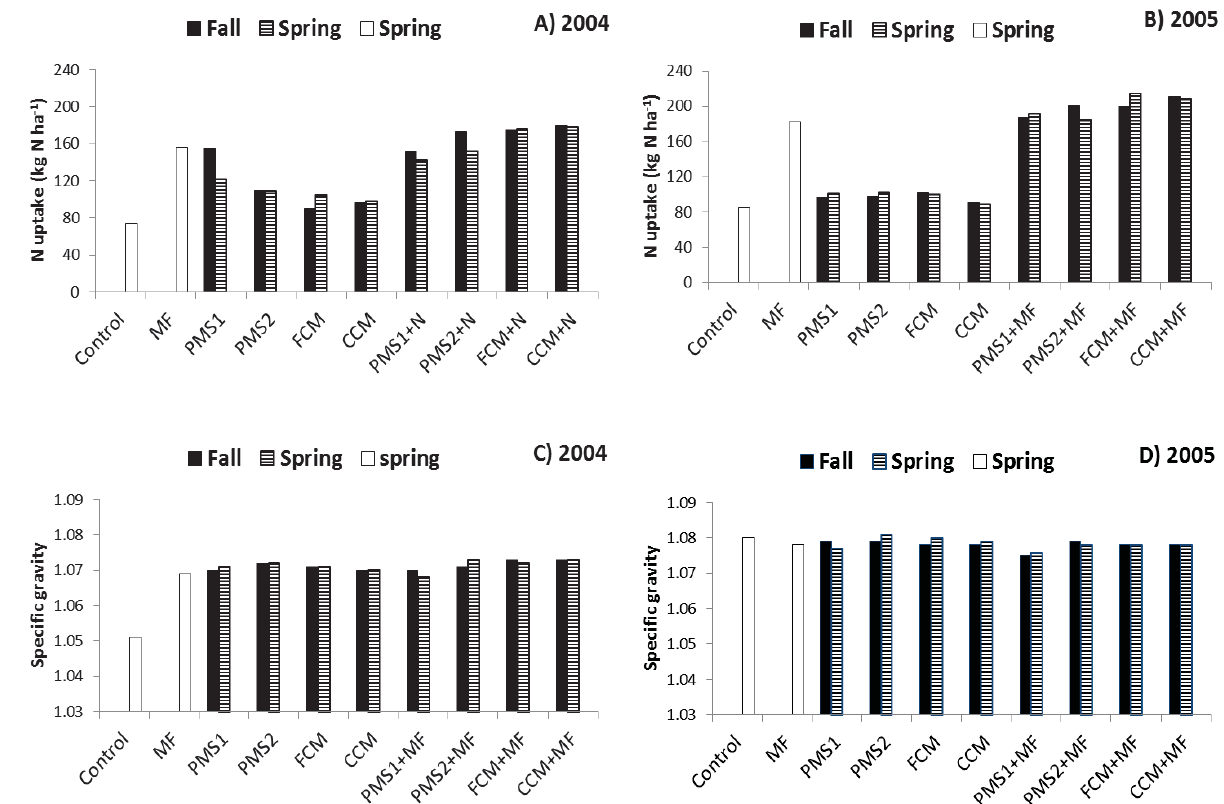
Figure 3. Effects of mineral N fertilization and organic amendments with or without N fertilizer (N) on total and N uptake ( A , B ) and specific gravity ( C , D ) in 2004 and